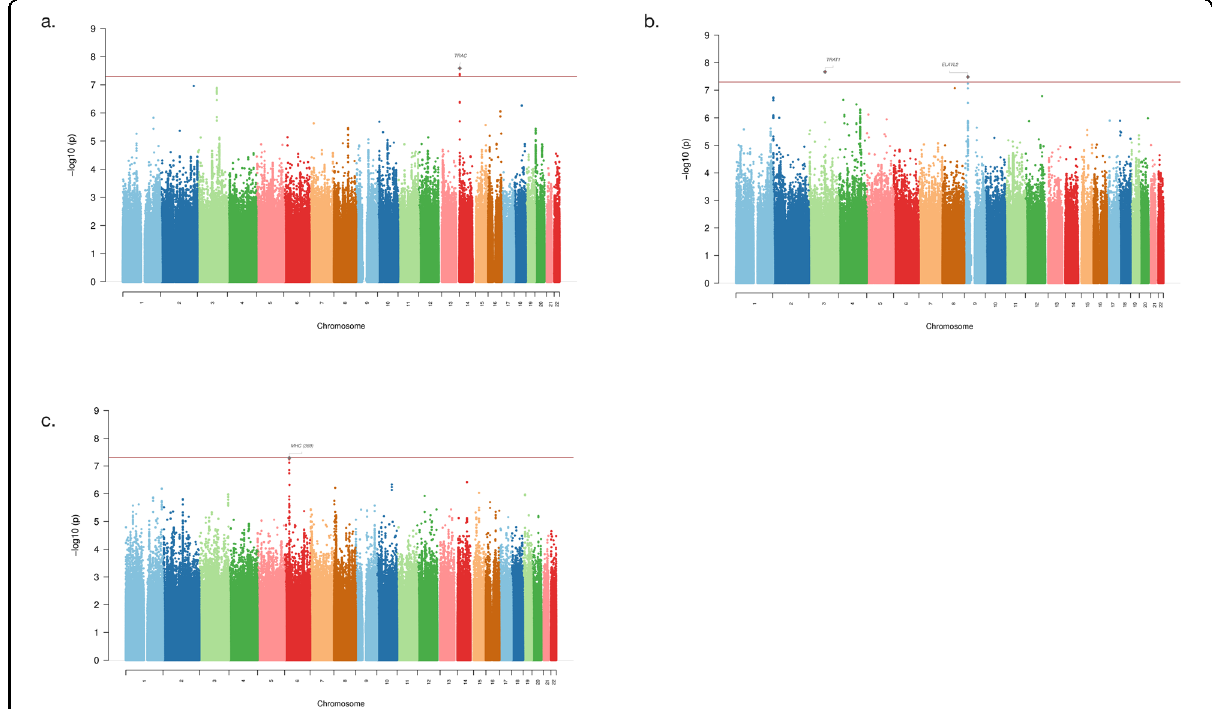
Fig. 2 Manhattan plots for GWAS analyses. a ) the CIL analysis (225 cases and 1,654 controls). b ) the CIN analysis (43 cases and 1,654 controls). c ) the trans-ancestry GWAS meta-analysis of CIN (43 cases and 1,654 controls) and CIAC (161 cases and 1,196 controls) datasets. -log10P values for analysis are shown.